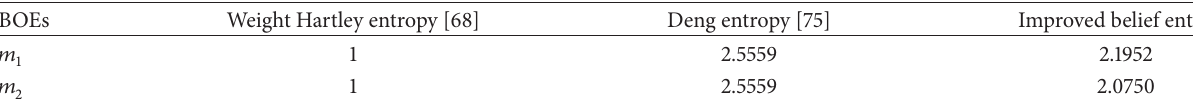
Table 2: Calculation results in Example